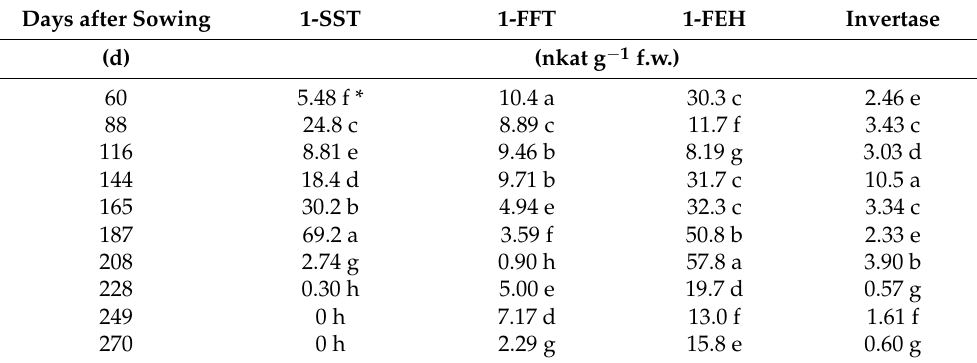
Table 3. 1-SST, 1-FFT, 1-FEH, and acid invertase (nkat g − 1 f.w.) variation during the growth cycle of wild cardoon. Days after